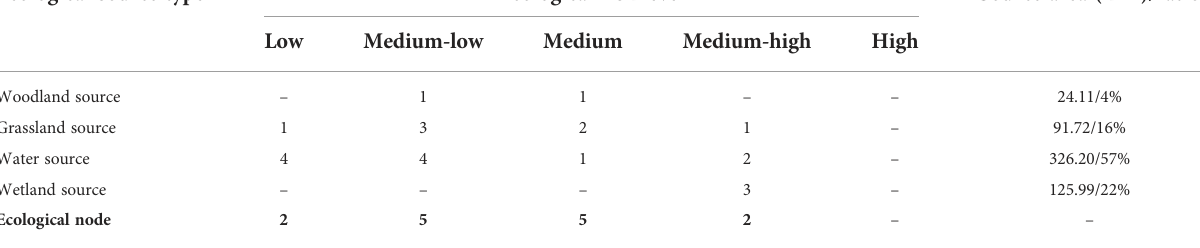
TABLE 3 Ecological source and risk